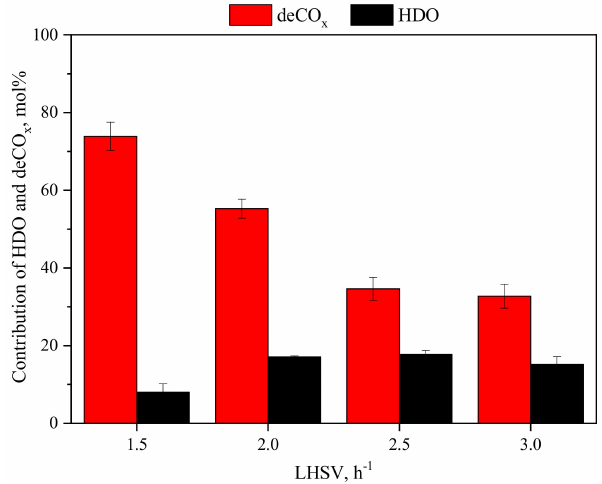
Figure 7. Contribution of HDO and DeCO x under di ff erent LHSV.